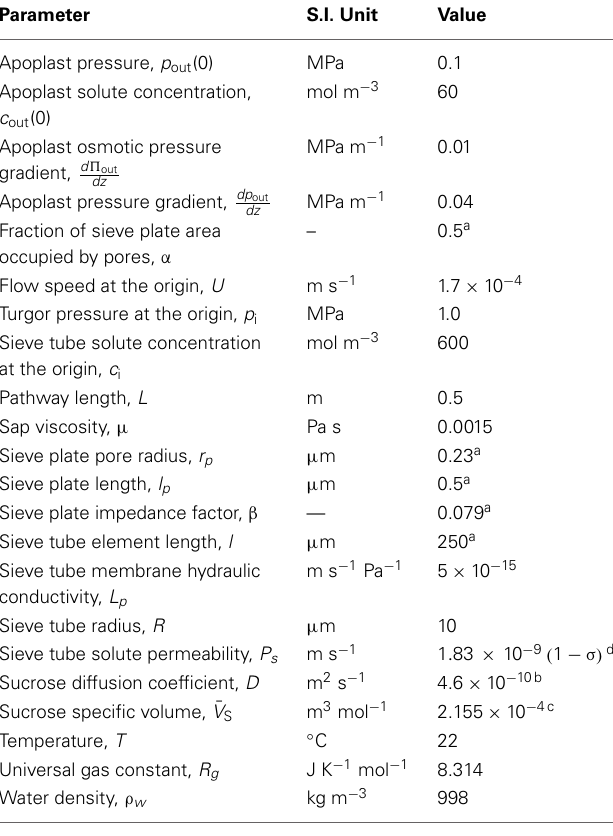
Table 1 | Values of the physical parameters chosen to represent the phloem.